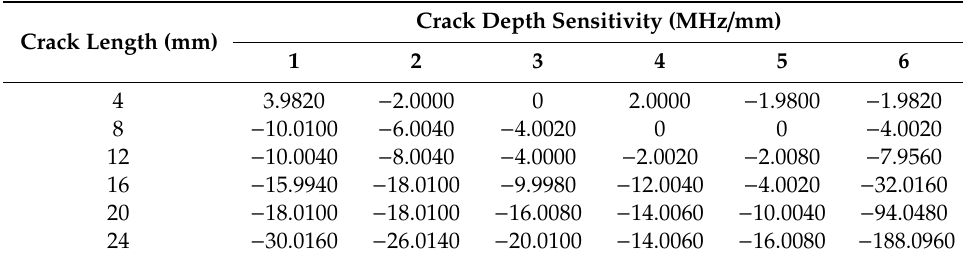
Figure 6. Relationship between the resonant frequency and the crack depth associated with different crack lengths. Table 3. Identification sensitivity of the crack